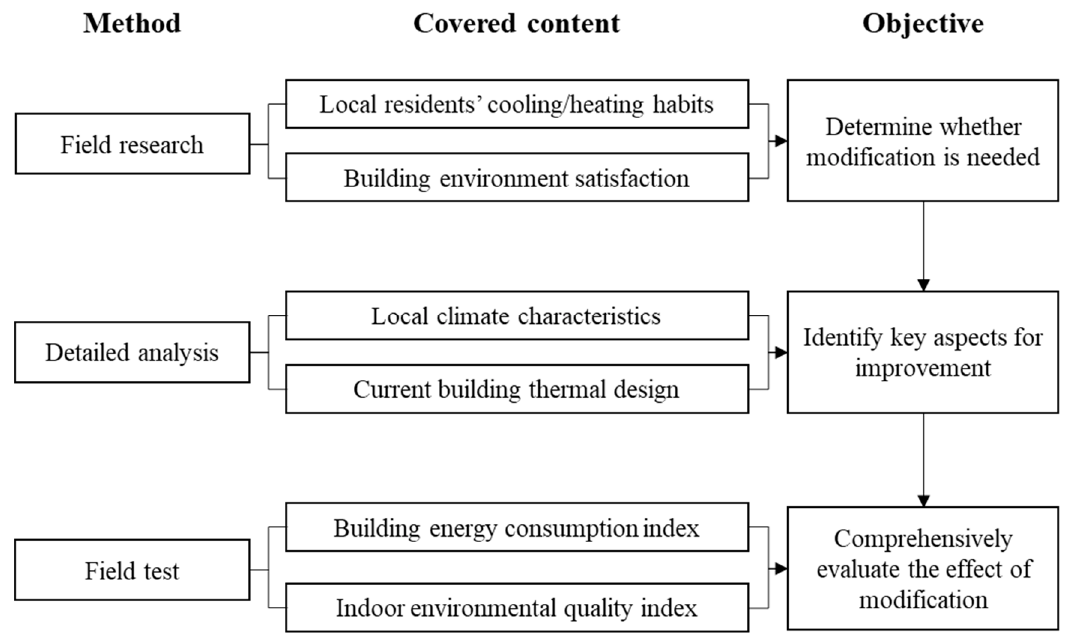
Figure 1. Flow chart of the modification method of building energy-saving design proposed in this study.